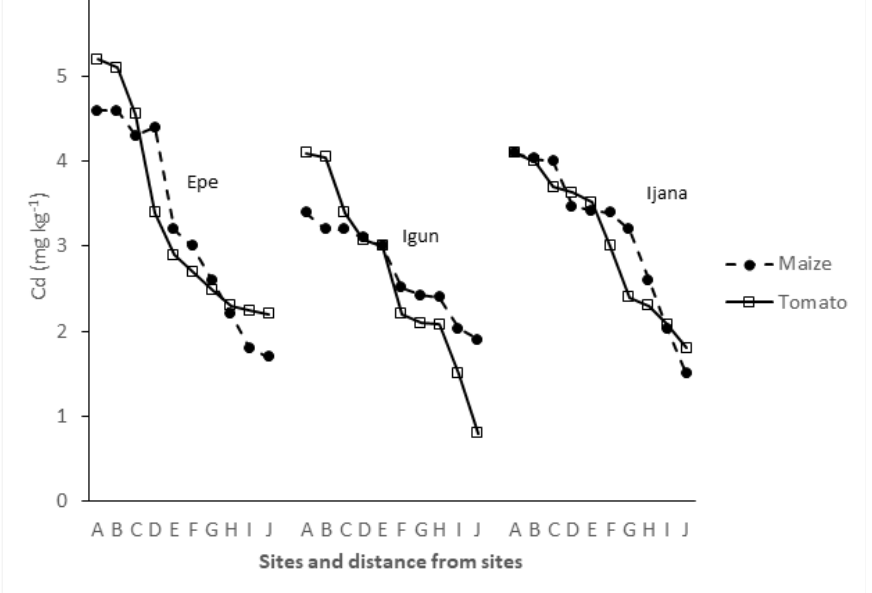
Figure 5: Concentrations of Cd in maize and tomato crops at Epe, Igun & Ijana (0 – 900 m) sites. A = 0 m from site; B = 100 m from site; C = 200 m from site; D = 300 m from site; E = 400 m from site; F = 500 m from site; G = 600 m from site; H = 700 m from site; I = 800 m